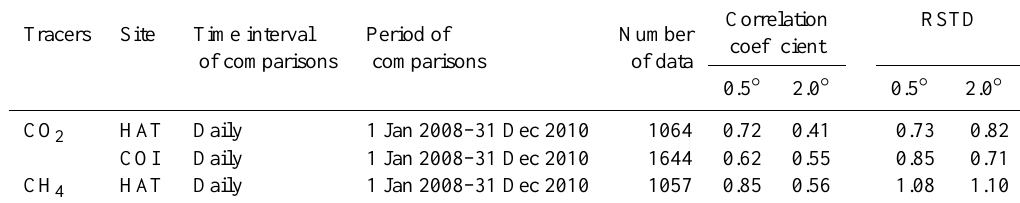
Table 3. Correlation coefficients and Ratio of standard deviation between synoptic variations, that is, detrended and deseasonalised variations in observed and simulated CO 2 and CH 4 concentrations at HAT (Hateruma), Cape Ochi-ishi (COI). “0.5 ◦ ” and “2.0 ◦ ” indicate 0.5-degree simulation and 2.0-degree simulation, respectively. Statistics are defined as in Table 1. Time interval Period of